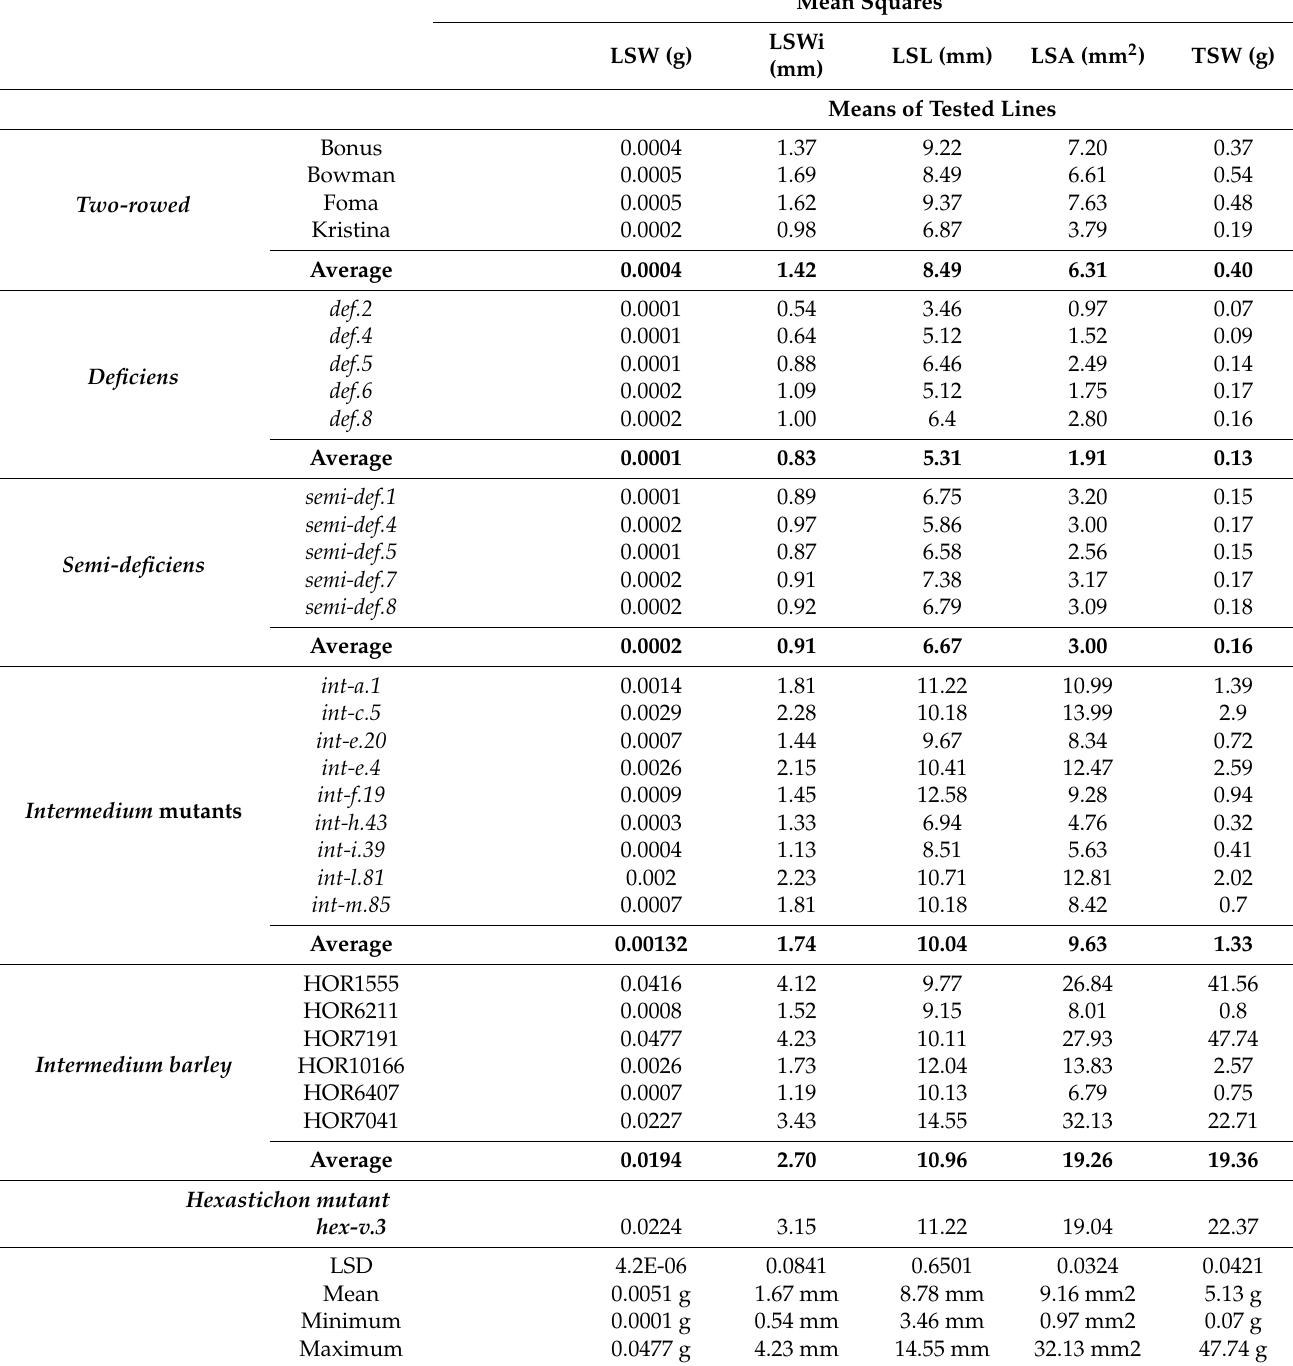
Table 1. The statistical analysis of the lateral spikelet traits in the set of 30 barley lines used in this study. Mean squares (MS) of lateral spikelet weight (LSW), lateral spikelet width (LSWi), lateral spikelet length (LSL), lateral spikelet area (LSA) and thousand seed or spikelet weight (TSW) in the tested